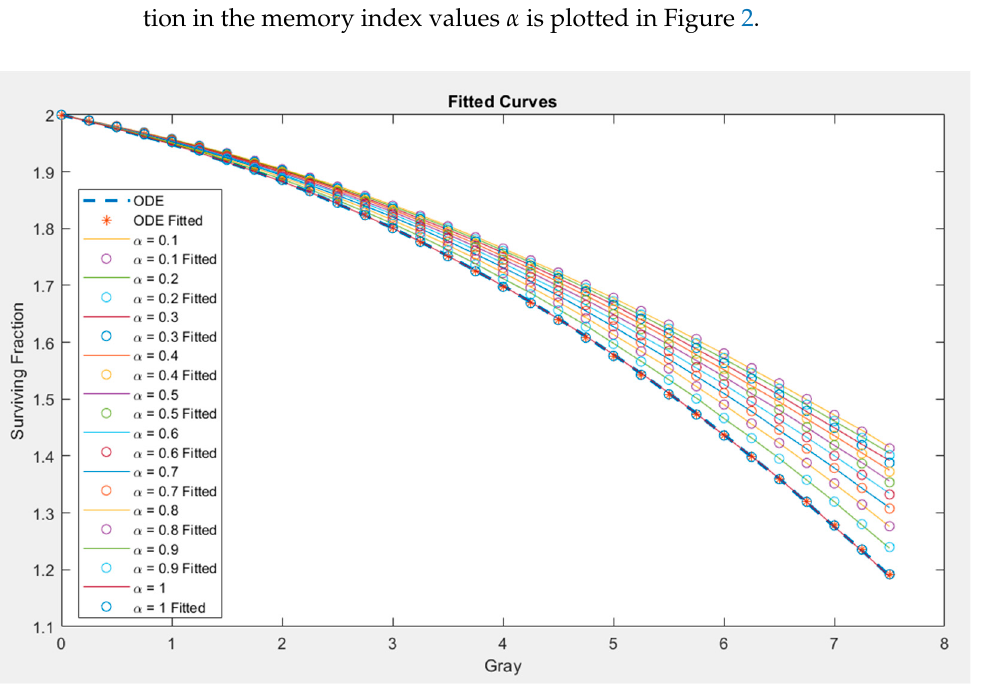
Figure 2. The cell survival curves for memory index 0 < 𝛼 < 1